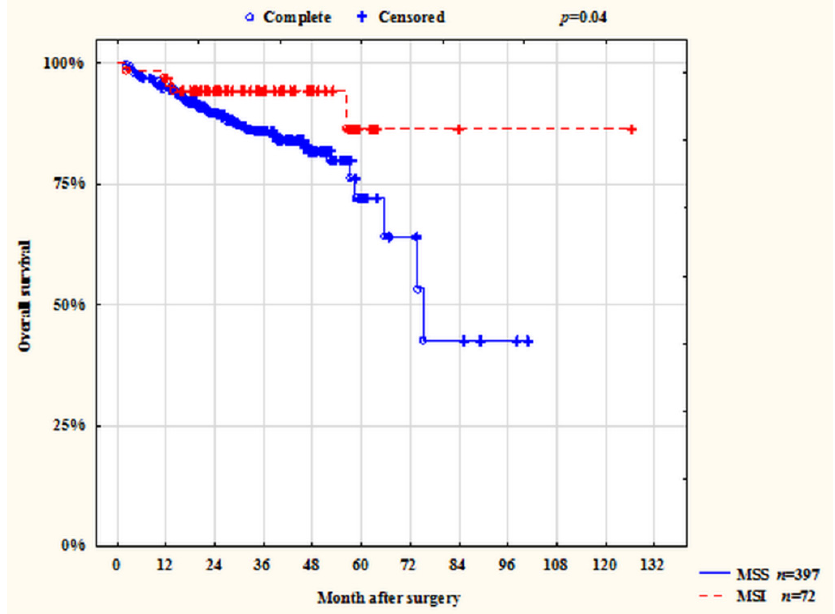
Figure 1. Overall survival of patients with CRC (stages I–IV) depending on the status of microsatellite instability.